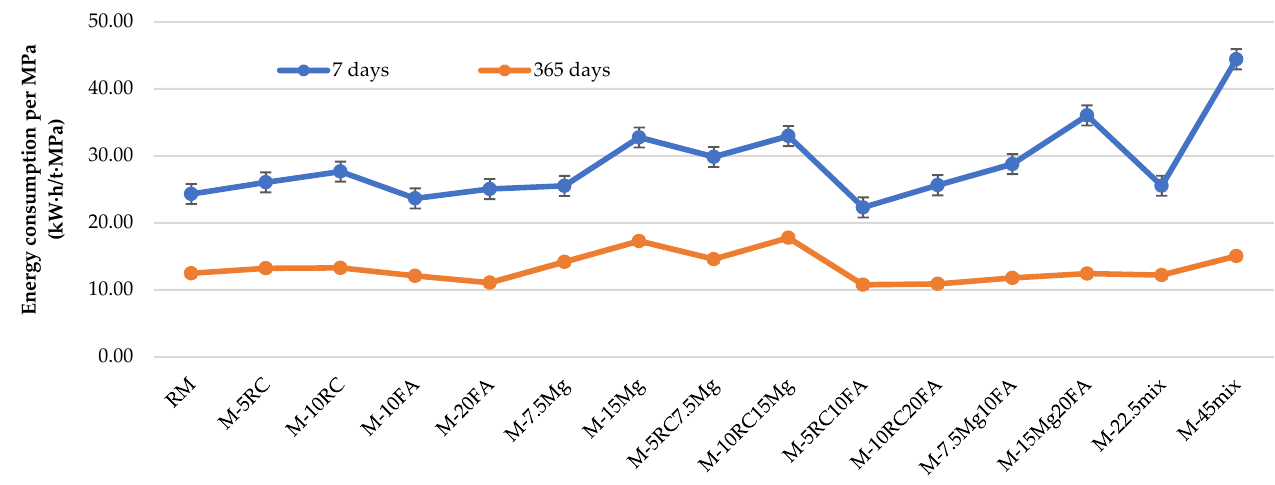
Figure 9. Energy performance at 7 days and 365 days of mortars.